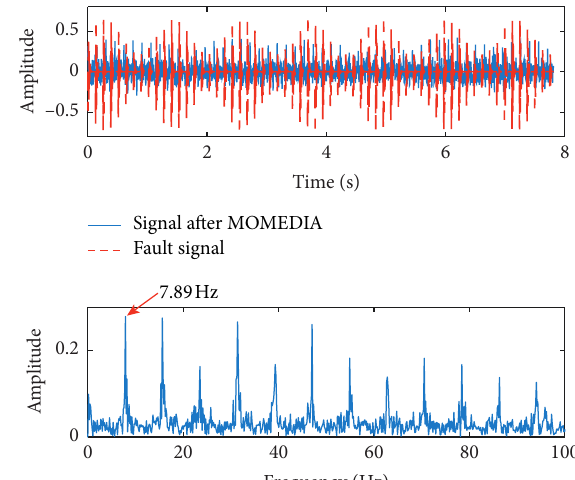
Figure 8: The filtered signal after MOMEDA.